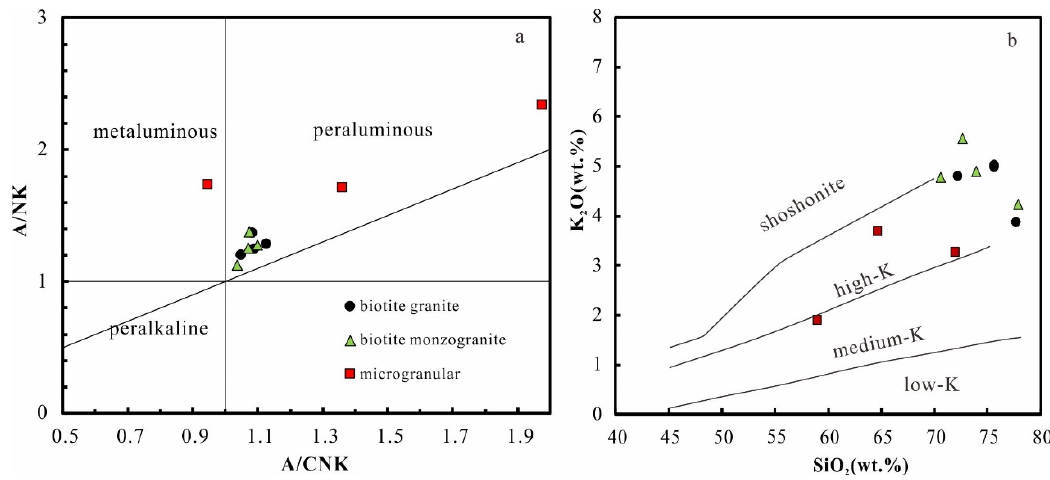
Figure 6. ( a ) A / CNK vs. A / NK diagram [53]; ( b ) SiO 2 vs. K 2 O diagram (solid lines from [54]).